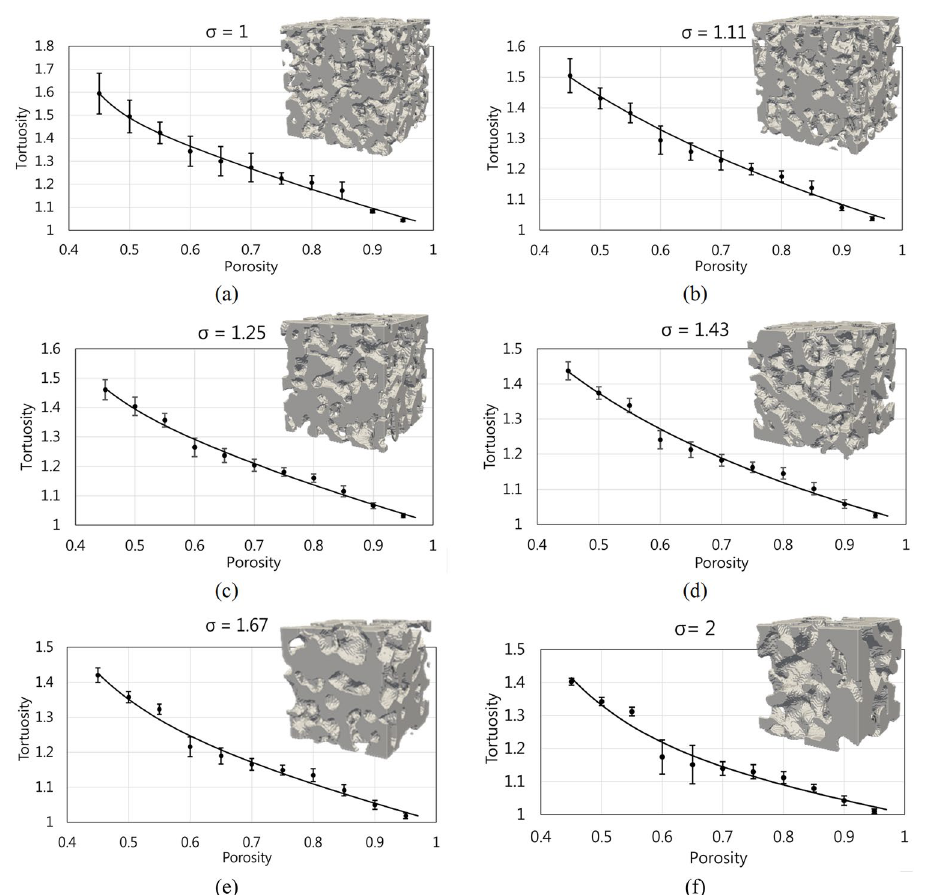
Figure 12. The continuous black line corresponds to the graph representation of correlations from Table 3. For each geometric tortuosity value, their corresponding standard deviation is presented. 3D rendering samples are presented to analyze the impact of the sigma value. All the selected samples correspond to the porosity of 0.5, and the sigma value increases according to its blobiness